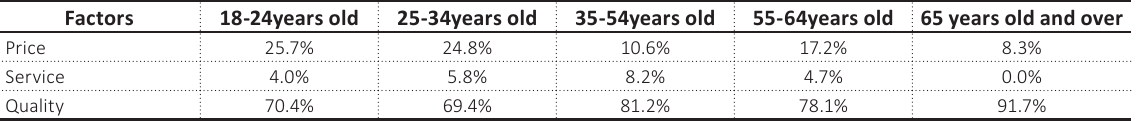
Figure 4. Responses to the question: Does advertising on agri-food products influence your choice? Does it push you for a purchase? Table 2. Results to the question: In general, which of the following factors encourages you to choose one of two similar products? Seen in terms of age Source: Constructed by the authors based on the data of the survey.